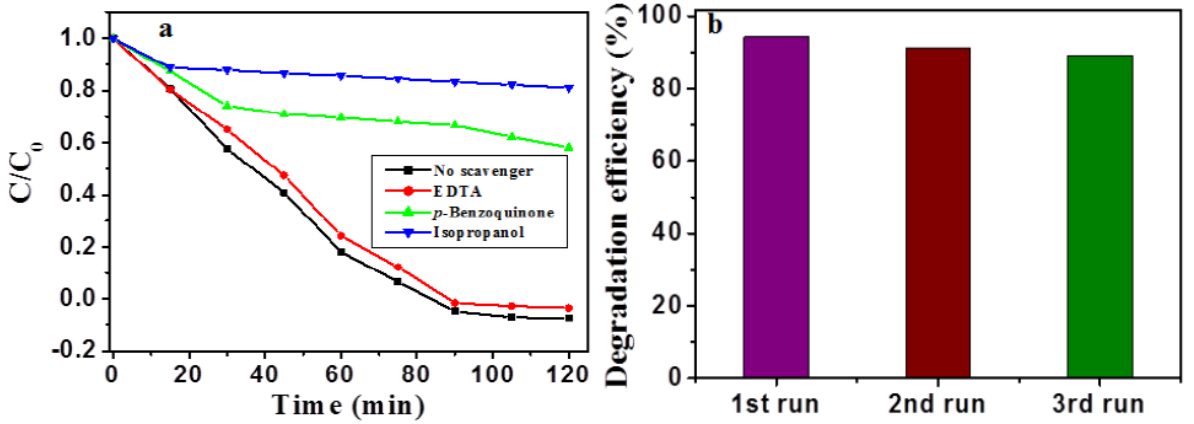
Figure 5. Degradation profile of methyl orange in the presence of scavengers ( a ); reusability of β -Nb 2 ZnO 6 nanoparticles ( A ) after 3 runs ( b ).